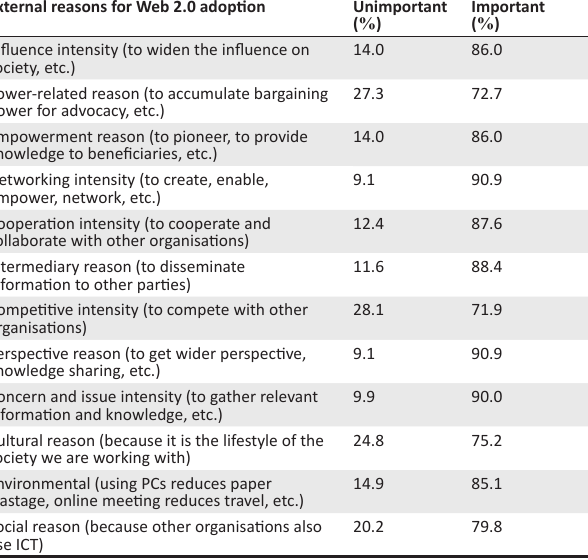
FIGURE 2: External reasons for Web 2.0 adoption in South African civil society organisations.